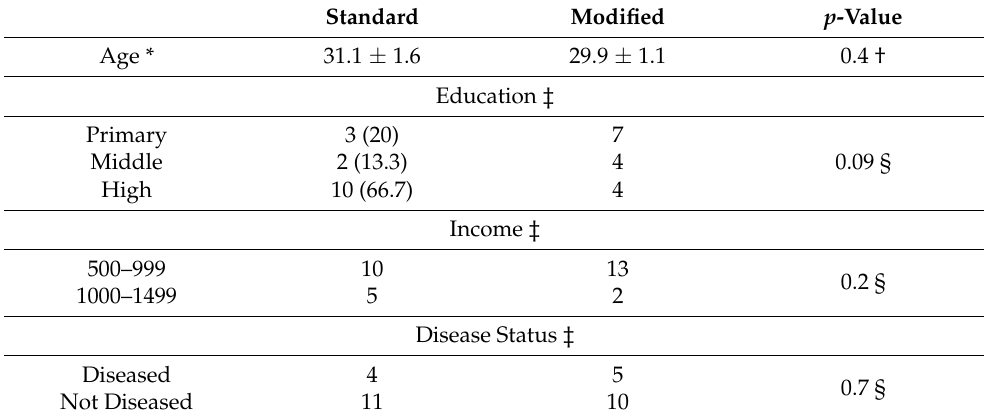
Table 1. Sample characteristics for participants in modified & standard group ( n = 30).